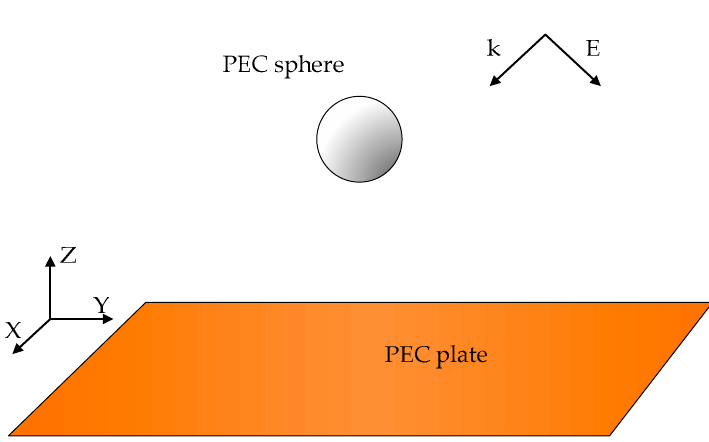
Figure 4. PEC sphere-plate composite object. The PEC sphere radius r s is 1 m; the PEC plate’s sides are l px = l py = 10m; and the distance D between the sphere’s center and the PEC plate’s surface is 5 m. For the first simulation, the incident wave was a plane wave excited by a Gaussian pulse modulation. During the simulation, the transient scattered field of the composite object was computed by DGTDPO. All the MoM results were obtained by ANSYS HFSS-IE solver. In addition, HFSS and Mie are defined as the references; the results computed by various methods of normalized root mean square deviation (NRMSD) were used to estimate the deviation.